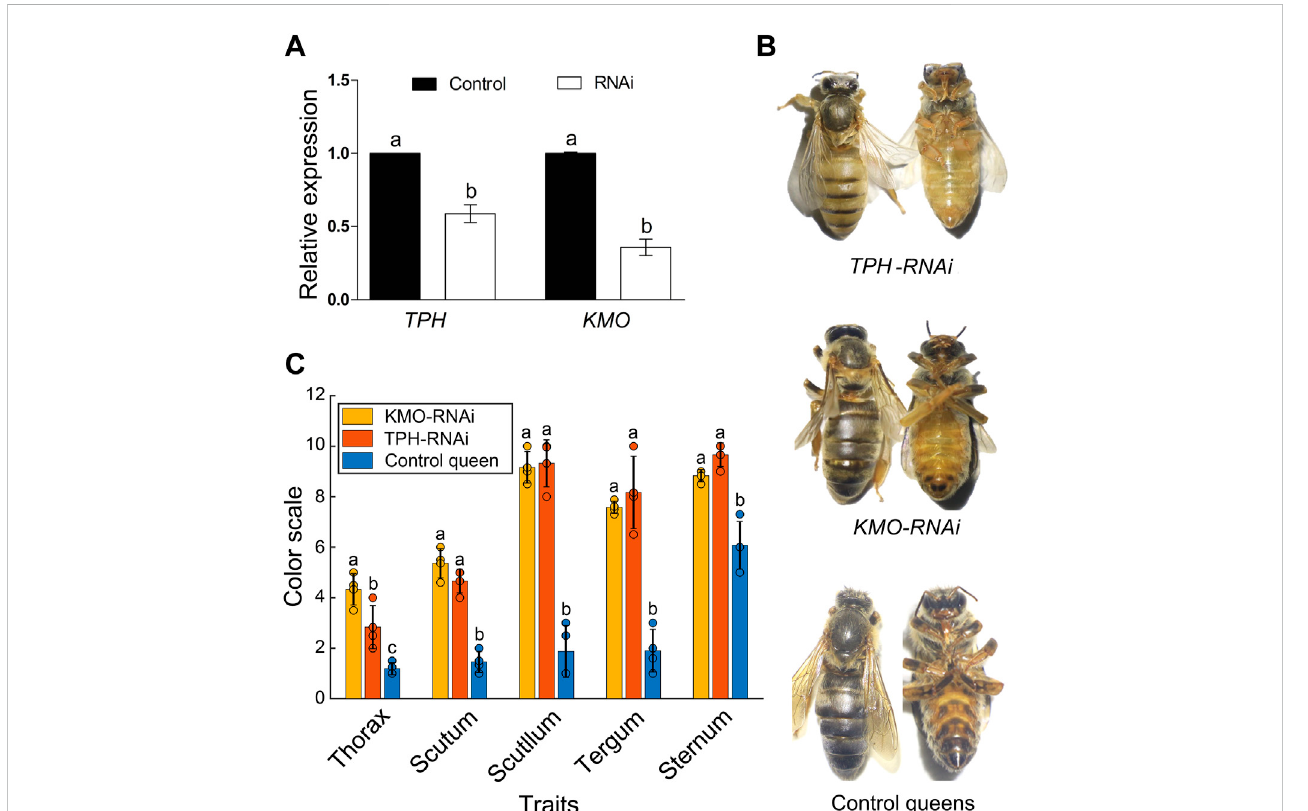
FIGURE 4 (A) The expression of TPH1 and KMO genes in 4-day A. cerana queen larvae by RNAi. Bars represent mean ± SD values of relative gene expression. Different letters on the top of each bar represent the signi fi cant difference ( p < 0.05, independent-sample t -test). (B) The body color alternation of A. cerana queens in RNAi experiment. The upper queens with a yellow body color are TPH1- RNAi group, the middle ones are KMO RNAi group with slight body color changes compared to control bees. The lower ones are control queens fed with negative siRNA. (C) The body color quanti fi cation of KMO -iRNA ( n = 4), TPH1- iRNA( n = 4),and control queens ( n = 4) based on Ruttner ’ scolor scales. Bars are present as values ofMean ± SD.Different letters on the top of thebars indicate signi fi cant differences( p < 0.0001F= 25.41Fcritical= 4.25,One-WayANOVA),thesame letterindicatesno signi fi cantdifference,and theblack dots on the top of each bar represent